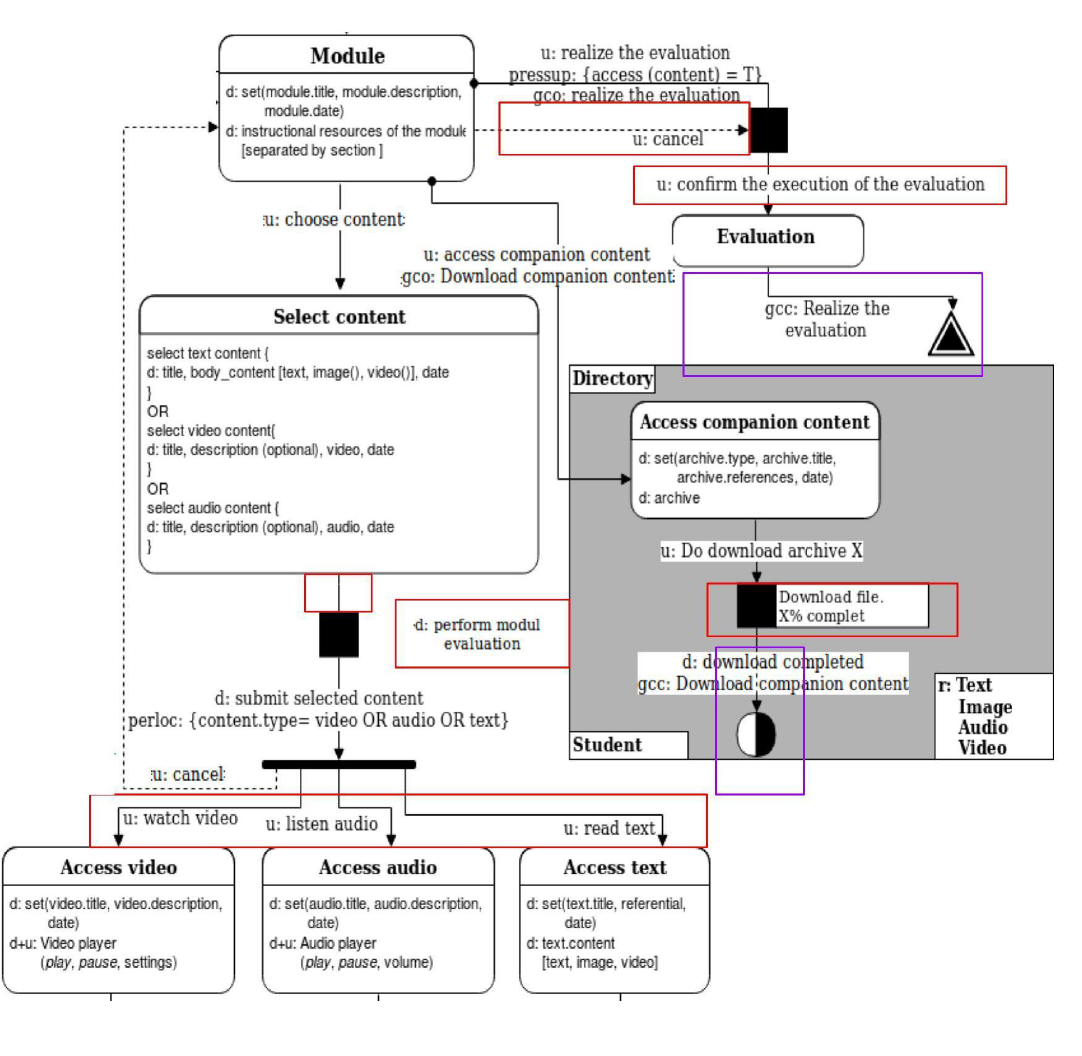
Figure 8. Course module diagram.